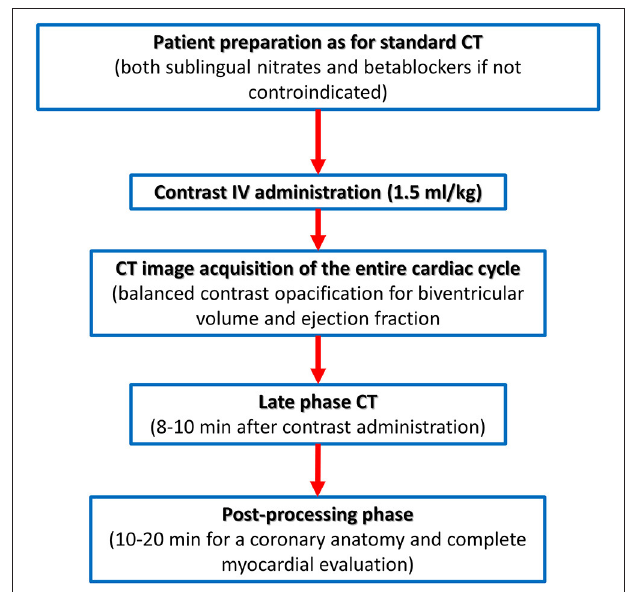
FIGURE 5 | Computed tomography acquisition protocol dedicated to biventricular myocardial function and tissue